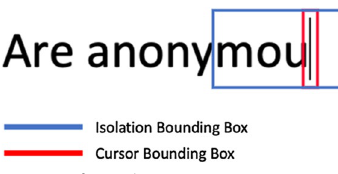
Fig. 3 IBB and CBB Illustration on Microsoft